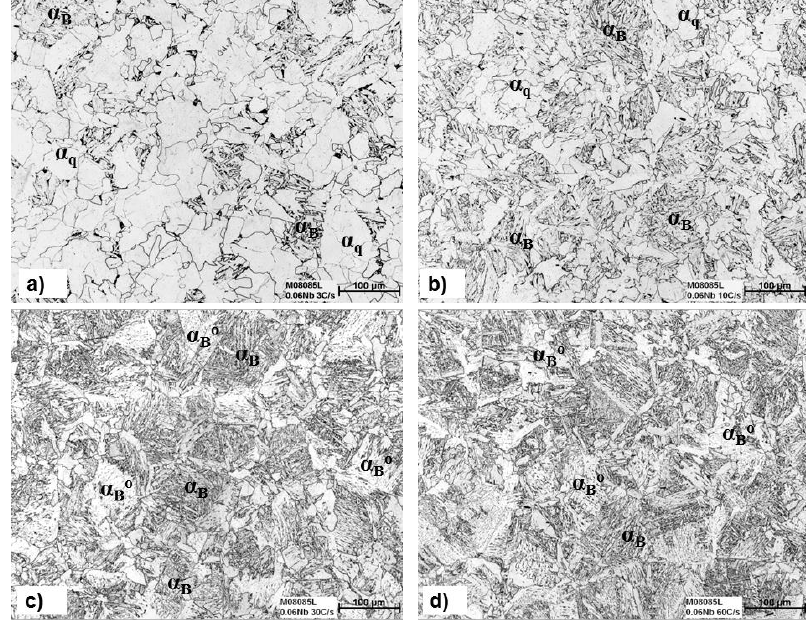
Figure 9. Optical microstructures for 0.06% Nb UCS flat dilatometer samples cooled at ( a ) 3 °C/s α q + α B , ( b ) 10 °C/s α q + α B + ~α B °, ( c ) 30 °C/s α B + α B °, and ( d ) 60 °C/s